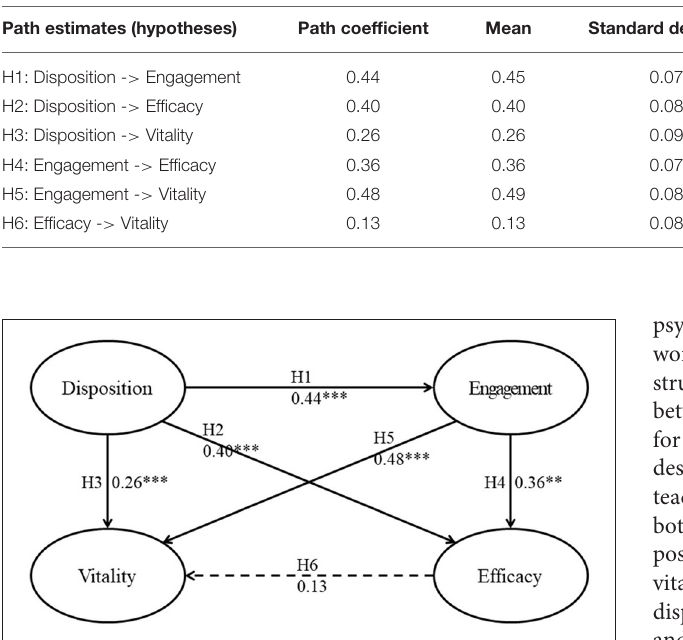
FIGURE 2 | Structural model of the design-associated variables of teachers. ** p < 0.01, *** p <